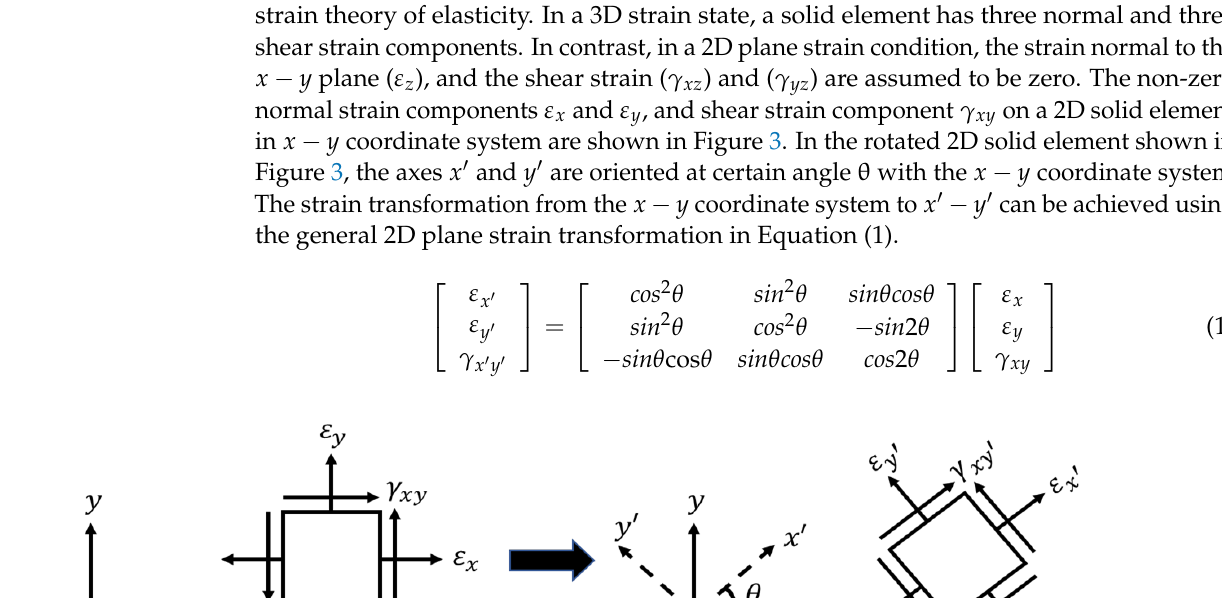
Figure 3. 2D solid element in: ( a ) 𝑥 − 𝑦 coordinate system; ( b ) 𝑥′ − 𝑦′ coordinate system